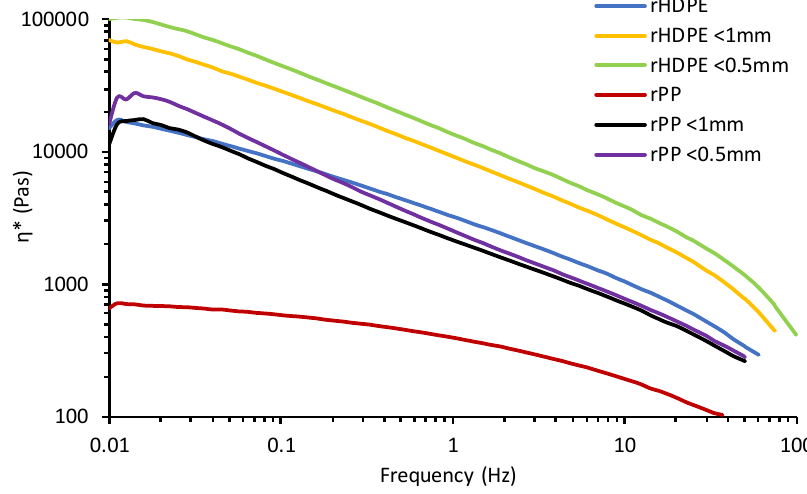
Figure 8. Flow curves of complex viscosity ( η *) of polyolefins and rice hull composites with frequency.